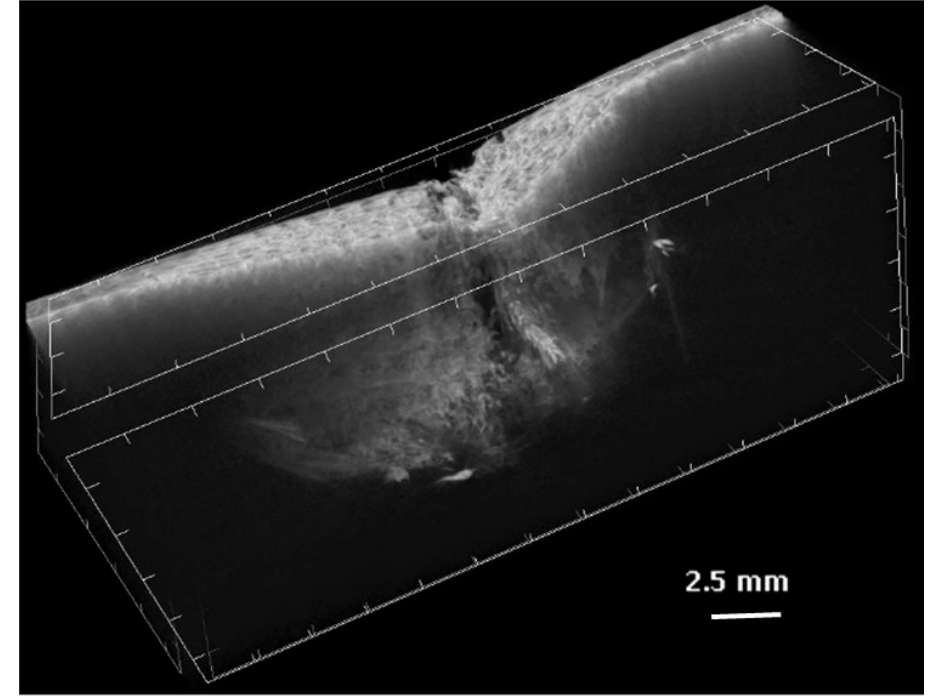
Figure 11. µCT analysis before and after the impact test of basalt fiber reinforced geopolymer composite. The part shows the area of impact.